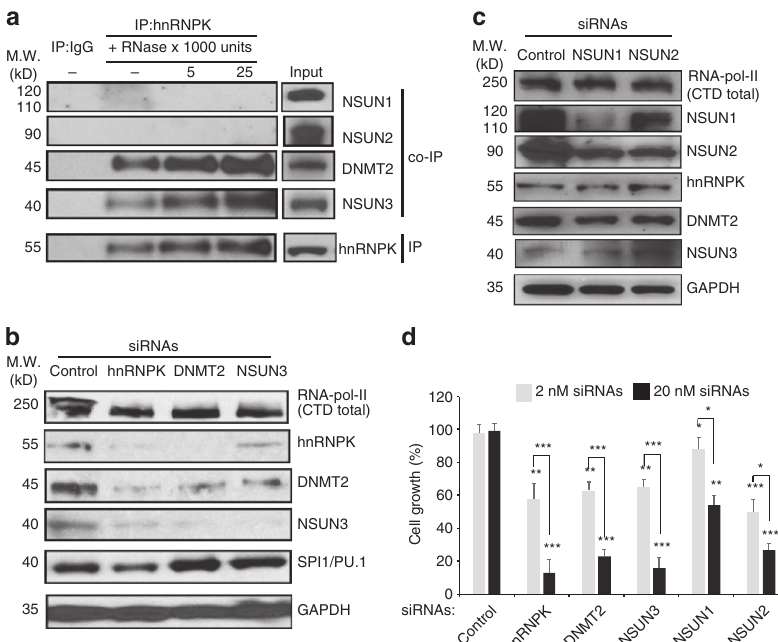
Fig. 2 Distinct functional hnRNPK/RCMT complexes required for leukaemia cell survival. a RNase digestion-coupled immunoprecipitation (IP) and co- immunoprecipitation (co-IP) to examine the interactions between hnRNPK and RCMTs, including DNMT2, NSUN3, NSUN1 and NSUN2, in OCI-M2 cells. b Measurements of the expression of hnRNPK, DNMT2, NSUN3 and other proteins in SC leukaemia cells treated with control siRNAs and the siRNAs targeting HNRNPK, DNMT2 and NSUN3 at day 3. c Measurements of the expression of NSUN1, NSUN2 and other proteins in SC leukaemia cells treated with control siRNAs and the siRNAs targeting NSUN1 and NSUN2 at day 3. d Measurements of the growth of SC leukaemia cells treated with control siRNAs and siRNAs targeting hnRNPK and individual RCMTs by MTT assay at day 3. Data are presented as the mean ± SEM of n = 3 independent samples. * P < 0.05, ** P < 0.01 and *** P < 0.001 by Student ’ s t (Fig. 3e, f). The negative and the background controls were done with the 1L + 2L and the 1L + 3R primer pair, respectively. Only a background level of PCR signals with the primer pairs (1L + 4R) located in the SPI1/PU . 1 promoter and enhancer was